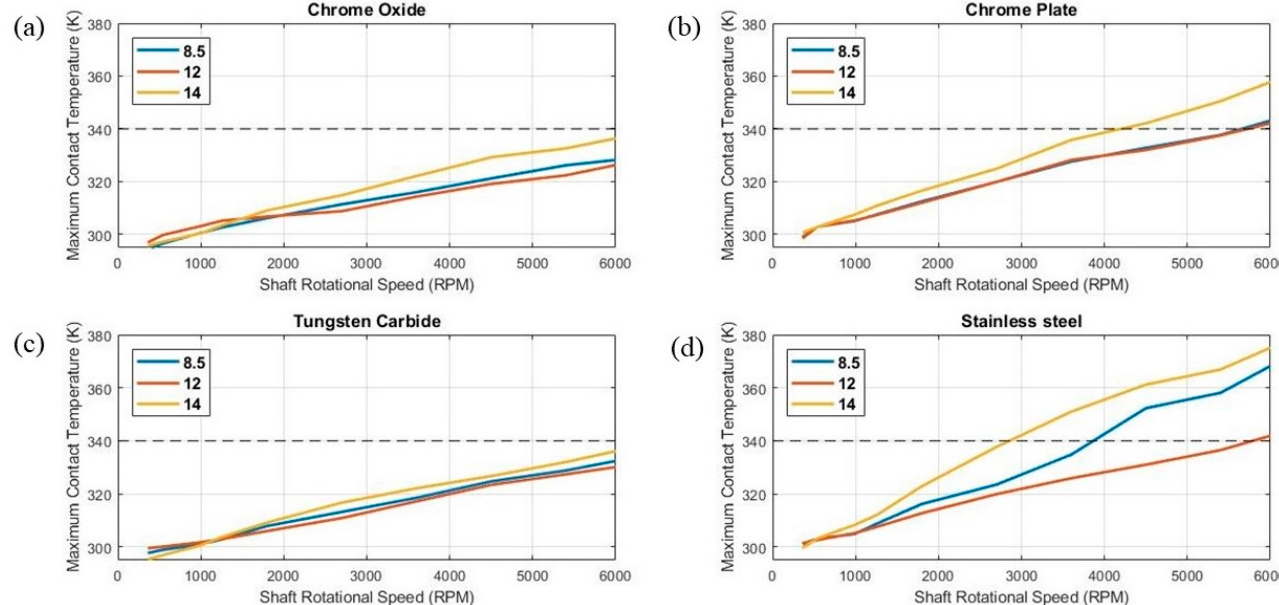
Figure 7. Maximum contact temperature at the sealing interface as a function of shaft speed for ( a ) Chrome Oxide ( b ) Chrome Plate (8.5 and 12 oz results overlap with one another and display almost identical trends, making the 8.5 oz line difficult to spot) ( c ) Tungsten Carbide and ( d ) Stainless Steel.